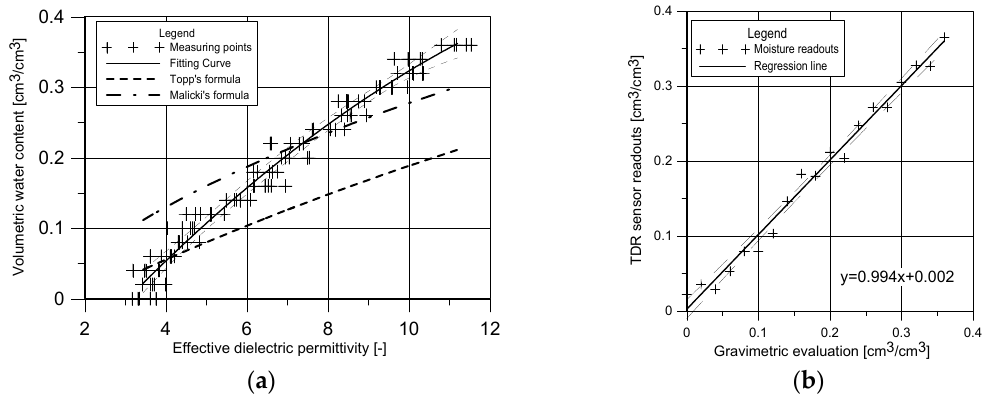
Figure 6. Calibration test results: ( a ) dependence between effective dielectric permittivity and material moisture, ( b ) comparison of data obtained gravimetrically and by reflectometric evaluation.